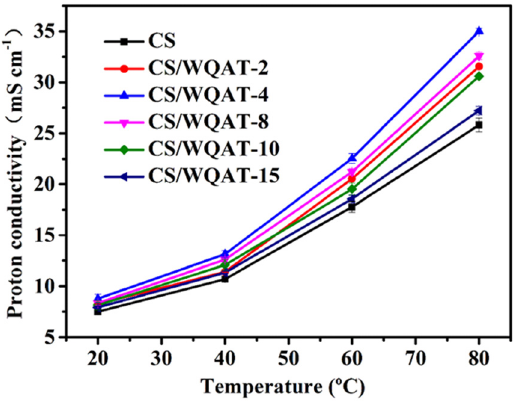
Figure 6. Proton conductivity of the composite membranes at different temperatures.